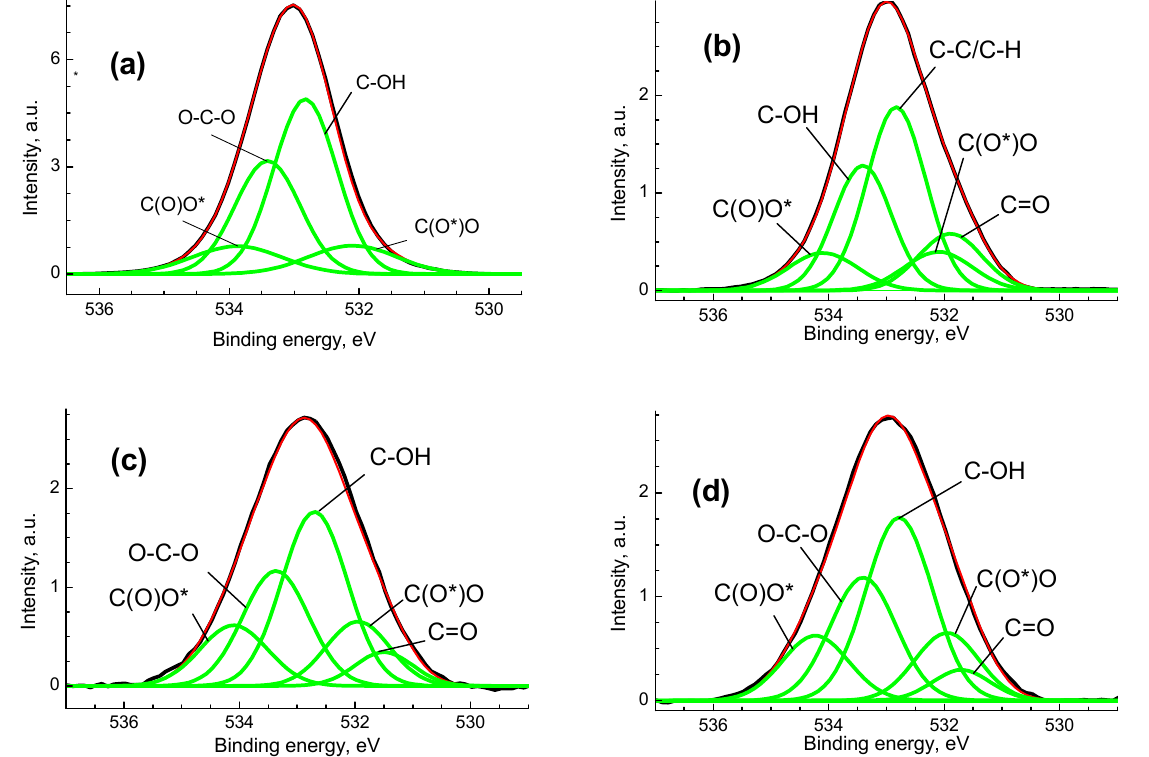
Figure 7. The O 1s photoelectron spectra for the BC ( a ), BCP ( b ), BC-Ag ( c ) and BCP-Ag ( d ), black—experimental, red—fitting, green—individual peaks.